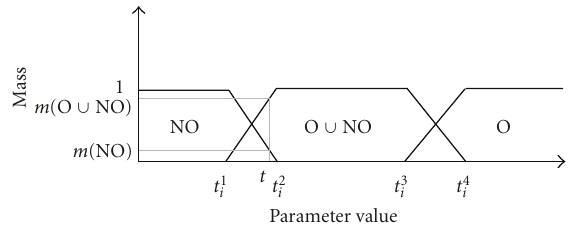
Figure 6: Definition of the mass functions.